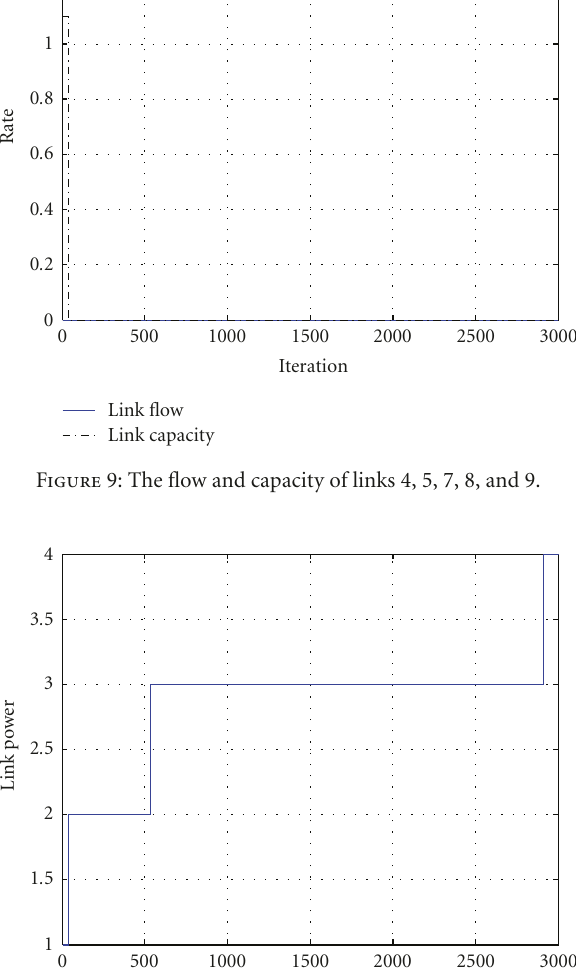
Figure 8: The flow and capacity of links 1,2,3, and 6.